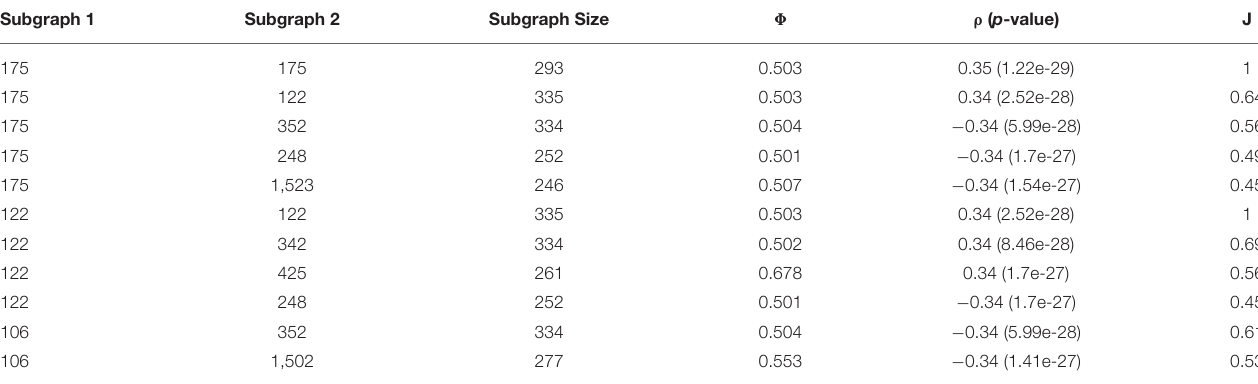
TABLE 8 | Top simultaneous PageRank subgraphs from visual